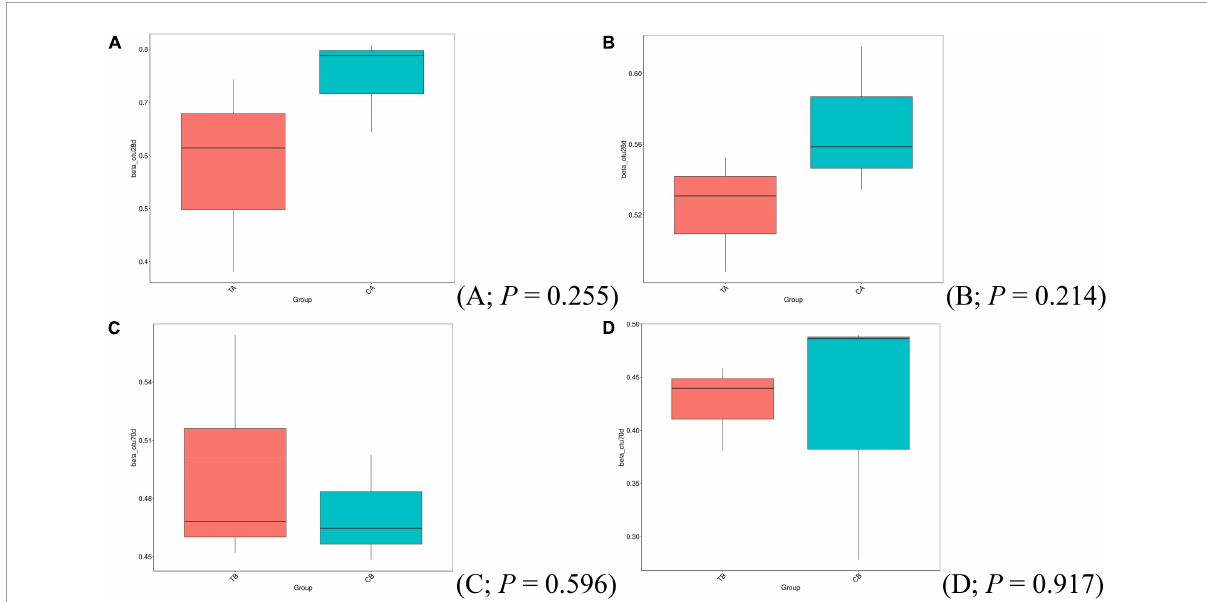
FIGURE3 Beta-diversity analysis of Bray–Curtis (A,C) and unweighted UniFrac (B,D) using t -test for intestinal microbiota of piglets on day 14 of age (14W) and day 28 of age (28W) at different sampling timepoints [day 28 of age (A,B) ; day 70 of age (C,D) ]. CA group was defined as the sample from piglets in 28W group at the timepoint of day 28 of age. TA group was defined as the sample from piglets in 14W group at the timepoint of day 28 of age (A,B) . CB group was defined as the sample from piglets in 28W group at the timepoint of day 70 of age. TB group was defined as the sample from piglets in 14W group at the timepoint of day 70 of age (C,D)